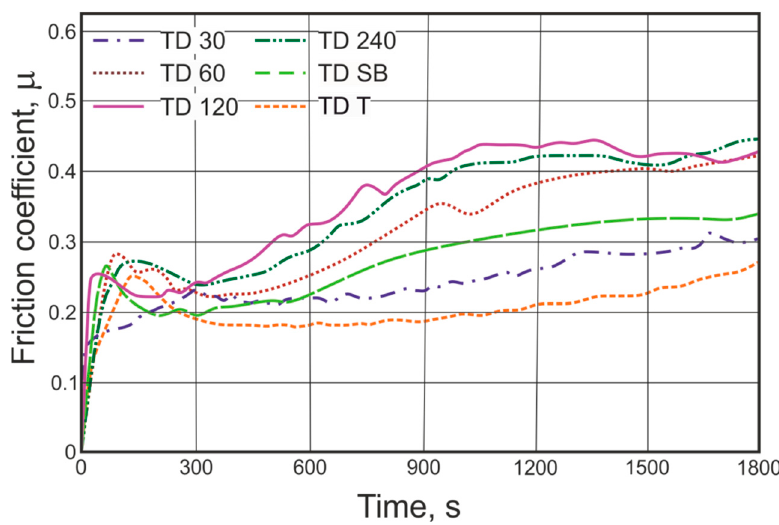
Figure 9. The friction coefficient values registered during pin-on-disc testing of TD zinc coatings.